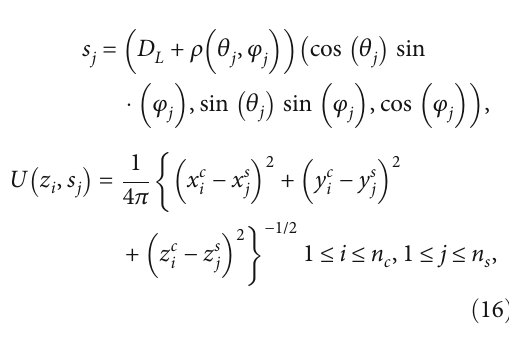
Table 1: Comparing the accuracy with di ff erent n